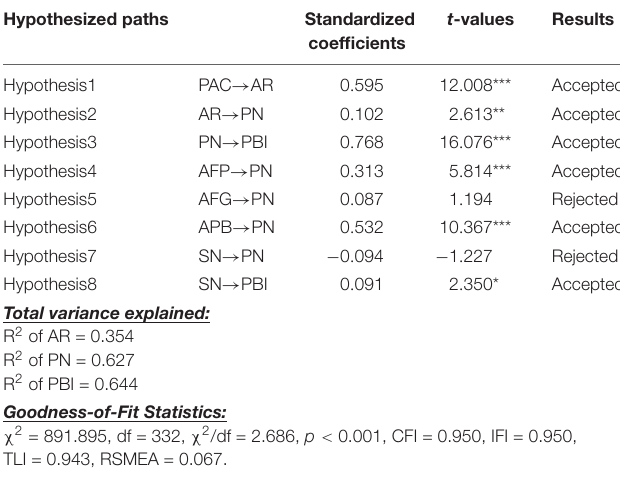
TABLE 4 | Hypotheses testing and the structural model